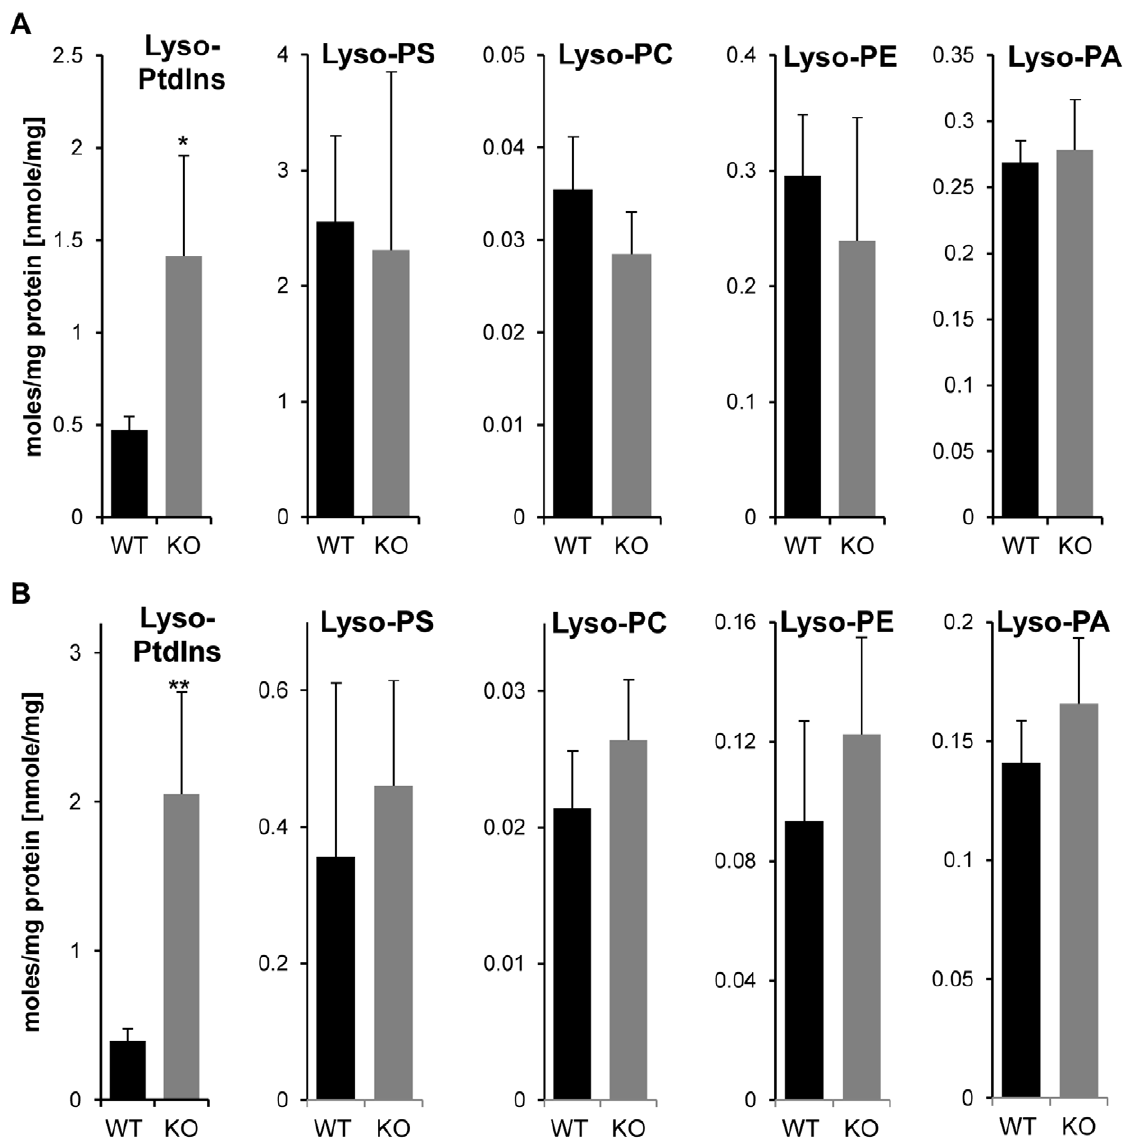
Figure 8. Effect of LPIAT1 knockout on brain and liver lyso-phospholipid molecular species. Brains ( A ) or livers ( B ) from 13 day old littermates expressing (LPIAT1 + / + (WT)) or lacking (LPIAT1 2 / 2 (KO)) LPIAT1 were ground, homogenized and lipids extracted from 0.5 mg wet weight as described in Materials and Methods. Lyso-phospholipids were targeted and were detected by MRM mass spectrometric anaylsis as described in Materials and Methods. Data are expressed as moles/mg protein, normalized to relevant internal standards. Shown are mean 6 SD, n=4 for both WT and KO. Data were analyzed by T-test. *p # 0.05, **p # 0.005.